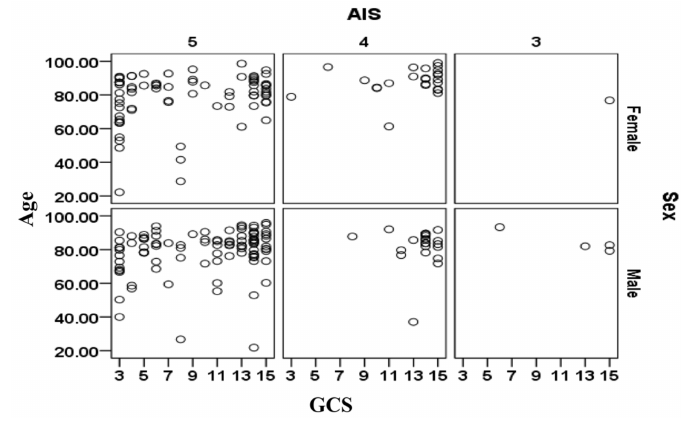
Figure 4. Relationships between age, sex, AIS and GCS for the subjects included in the validation dataset that had not